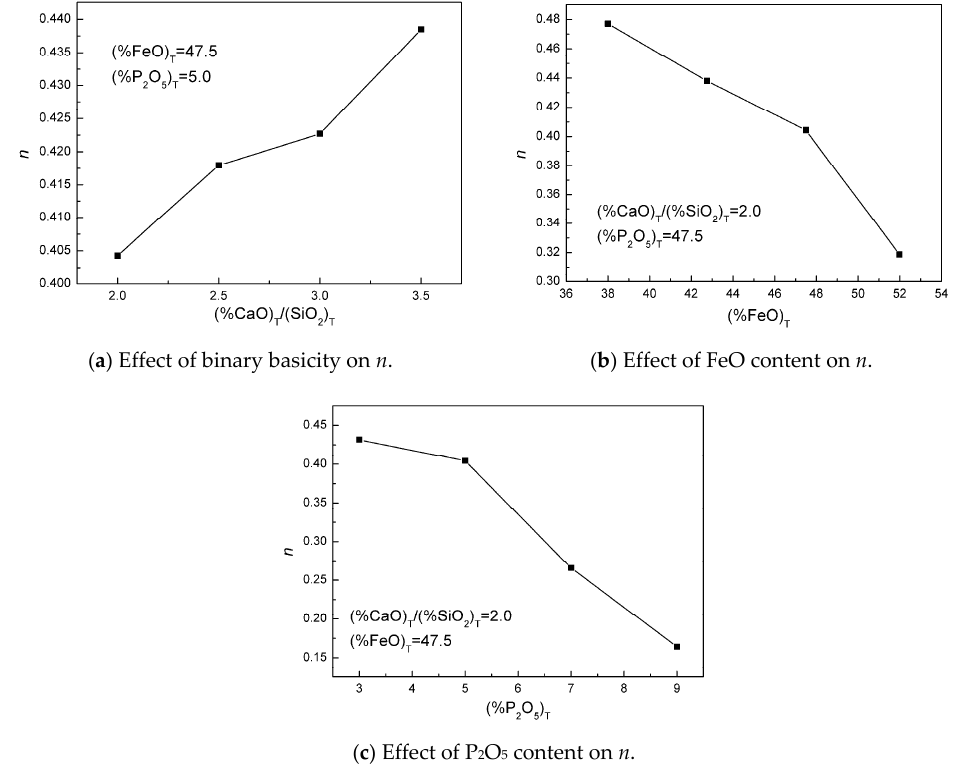
Figure 11. E ff ect of P 2 O 5 content in the solid solution phase on γ P Figure 11. Effect of P 2 O 5 content in the solid solution phase on Figure 11. Effect of P 2 O 5 content in the solid solution phase on